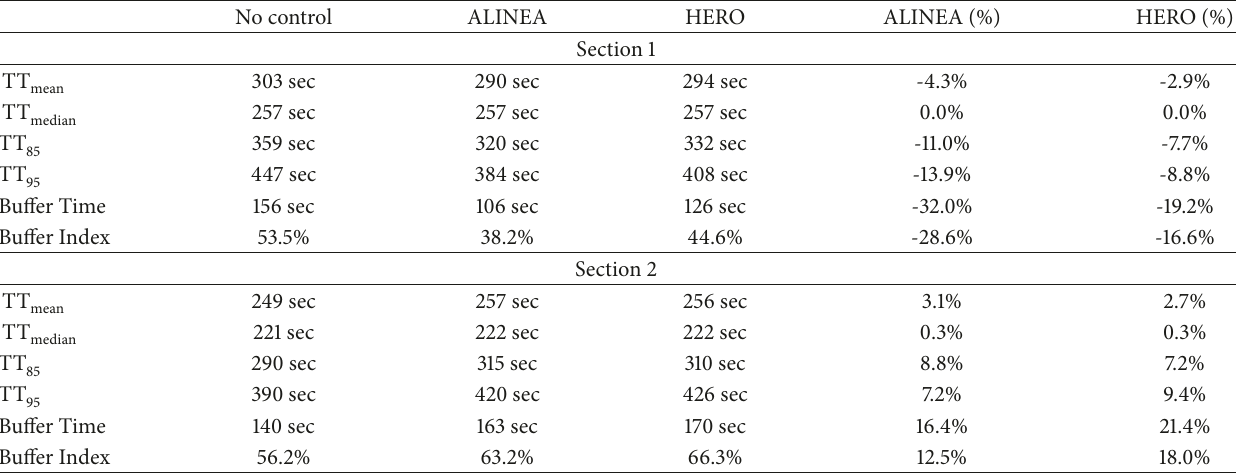
Figure 6: Travel time index for the entire simulation duration for (a) section 1 and (b) section 2. Table 4: Mean, median, 85 th percentile, 95 th percentile travel time, buffer time, and buffer index for the no control, ALINEA, and HERO ramp control per